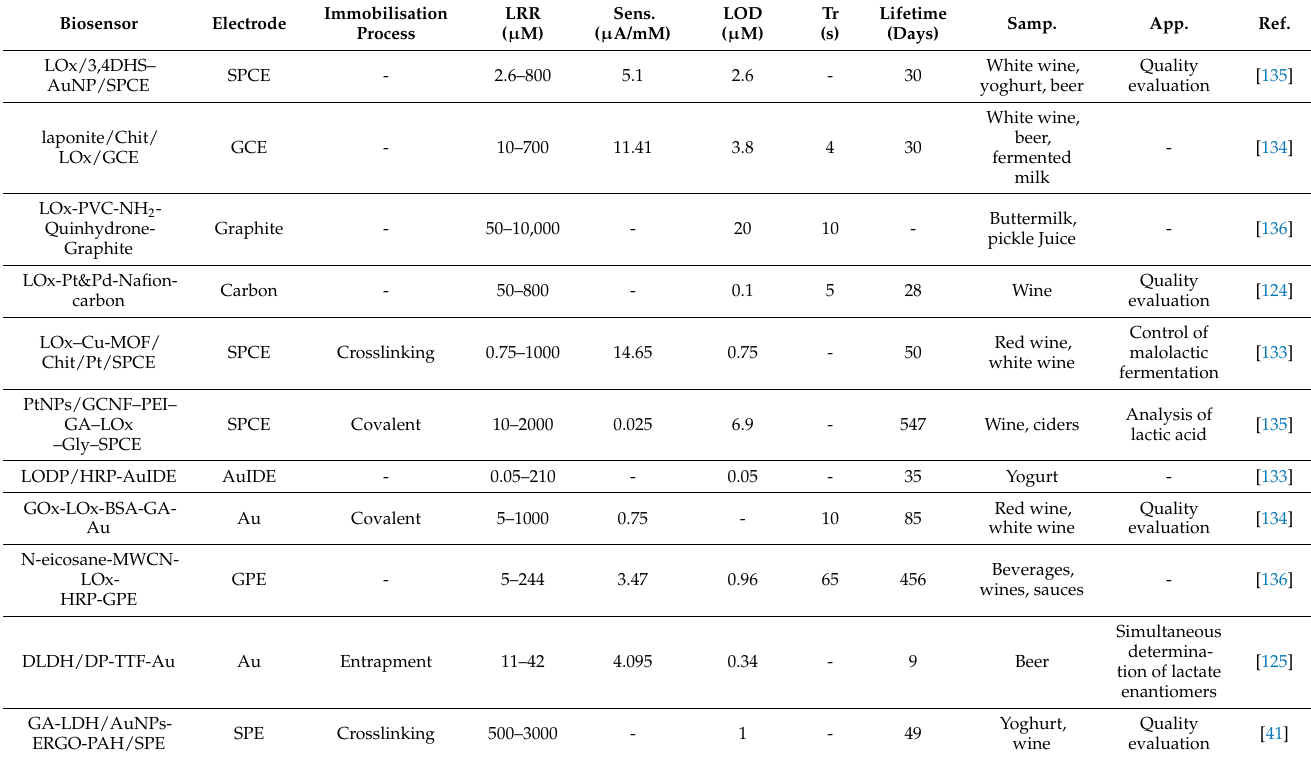
Table 3. Lactate biosensors employed for the analysis of food